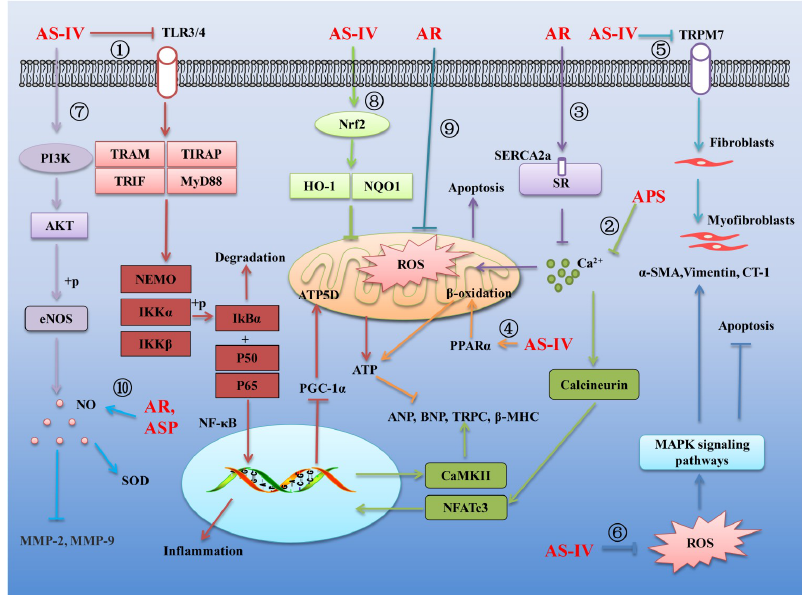
Figure 1. Several mechanisms linking AR and its main components to the treatment of cardiovascular diseases. Arrows and bar-headed lines represent signaling activation and inhibition, respectively. The different signaling pathways regulated by AR and its components are numbered ① to ⑩ .